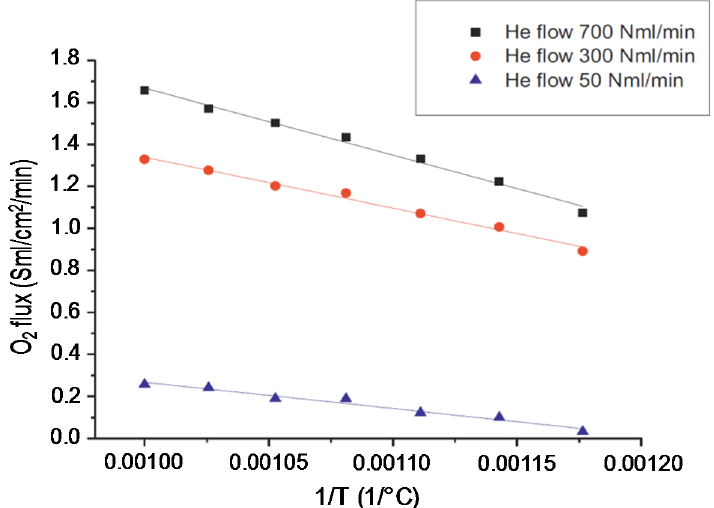
Figure 18. Arrhenius plot for the MIEC membrane (0.5 mm thickness) as a function of He flow rate in the permeate side with an air flow rate of 2000 mL N /min in the retentate